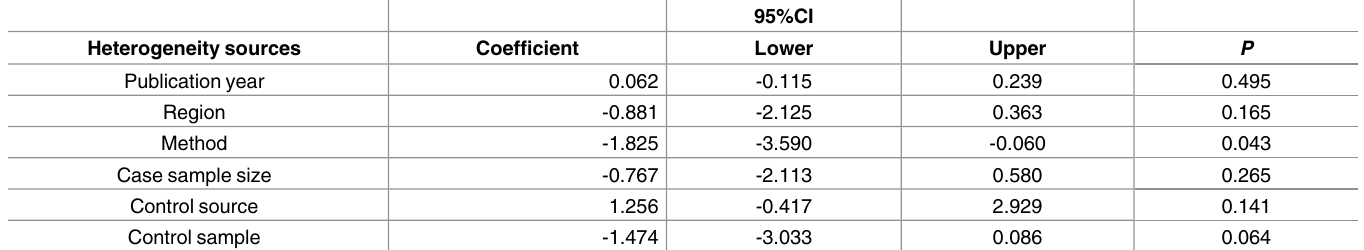
Table 3. Meta-regression analysisof DAPK promoter methylation and HNSCC.